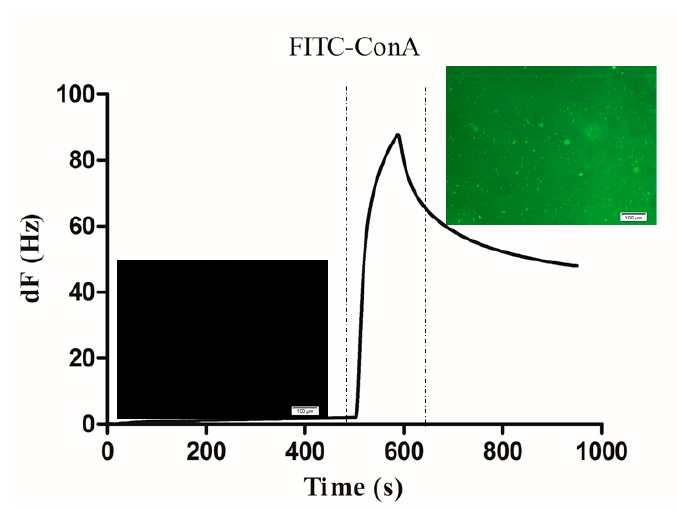
Figure 4. Binding of FITC-Con A to the carbohydrate chip. The scale bar is 100 µ m.